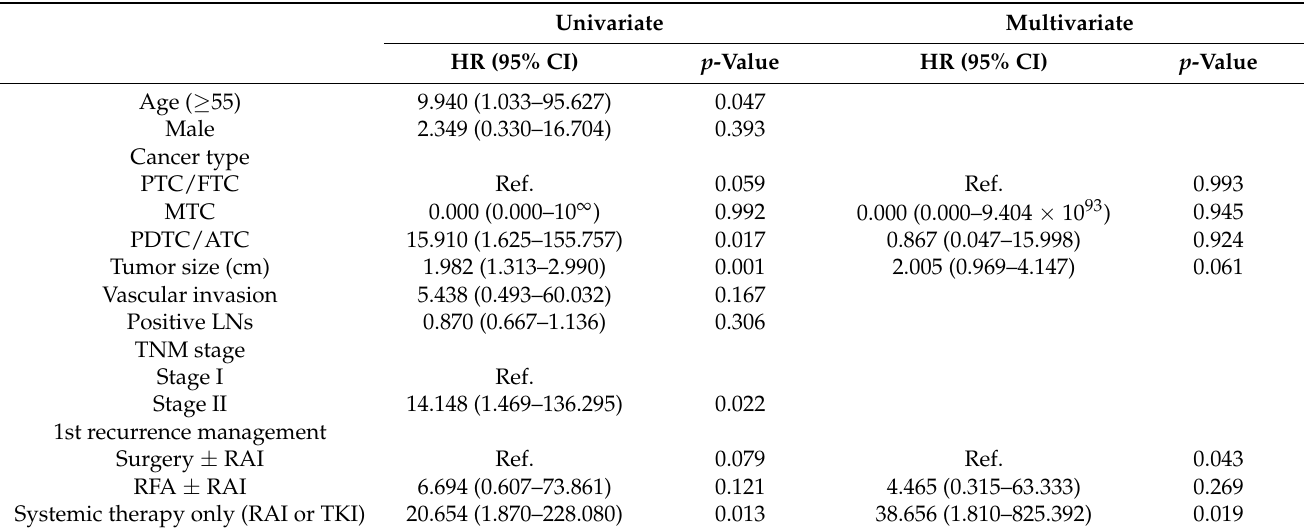
Table 3. Cox regression analysis of risk factors for mortality in patients with recurrent thyroid cancer.